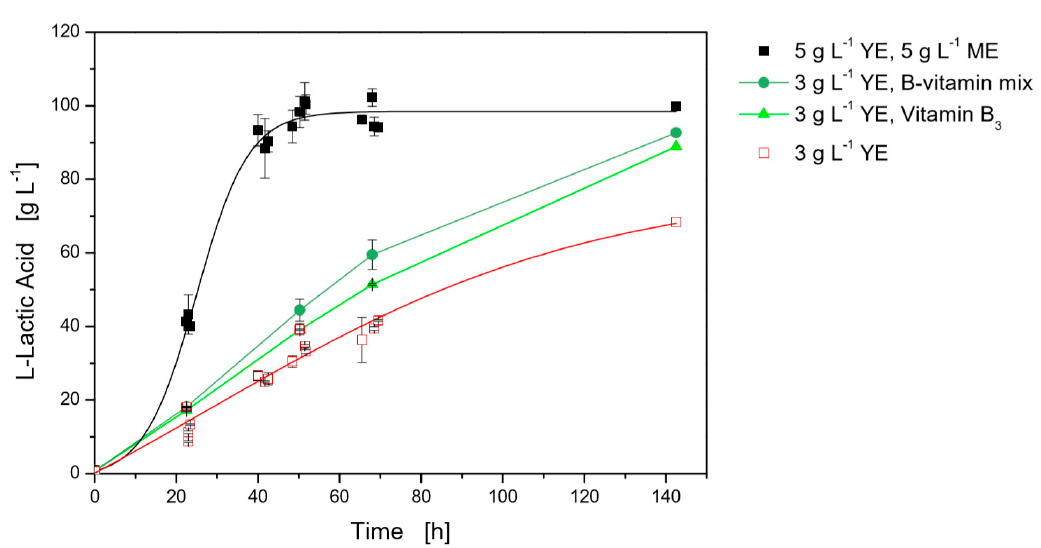
Figure 1. Influence of different B-vitamins on L -lactate production with L. casei in limited MRS medium with 3 g·L − 1 yeast extract in 24-well plates at 37 °C and 400 rpm. Black, closed squares modified MRS medium with 5 g·L − 1 yeast extract (YE) and 5 g·L − 1 meat extract (ME), red, opened squares limited MRS medium with 3 g·L − 1 yeast extract.